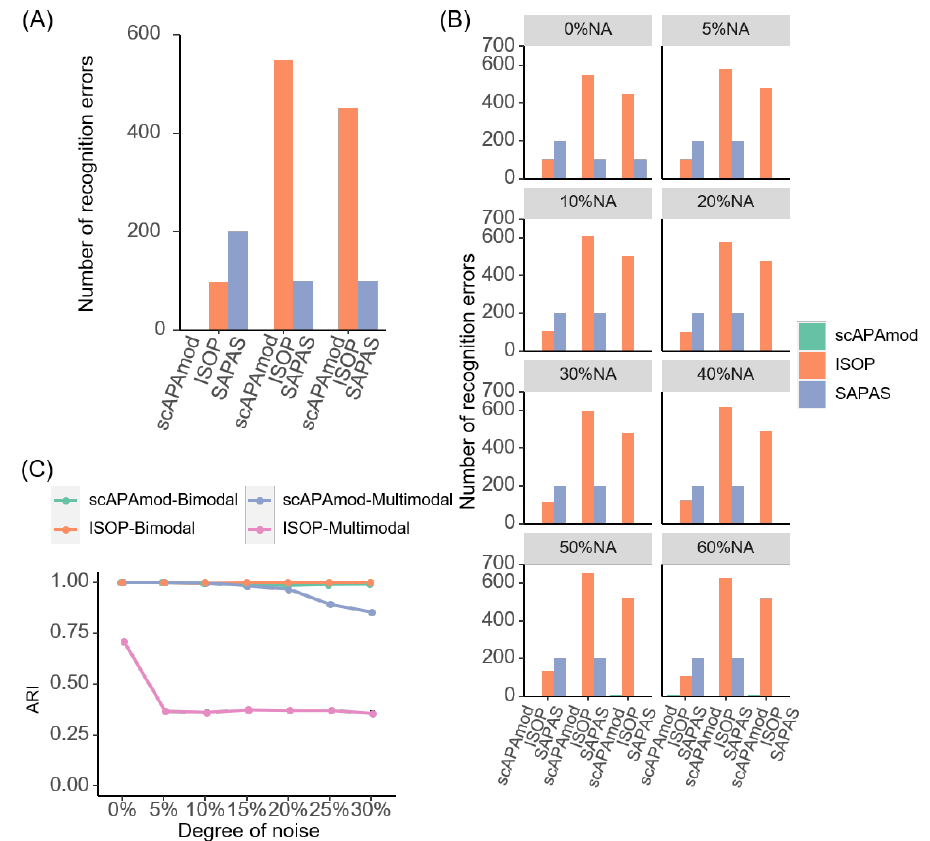
Figure 2. Simulation results of the 100-cell simulation data. ( A ) Number of recognition errors for different modalities using noise-free simulated data. ( B ) Number of recognition errors for different modalities using the simulated data with different degrees of missing values. ( C ) ARI of simulated data with different degrees of noise. Here, SAPAS was not included as it only outputs modality without information of cells in the identified modality.